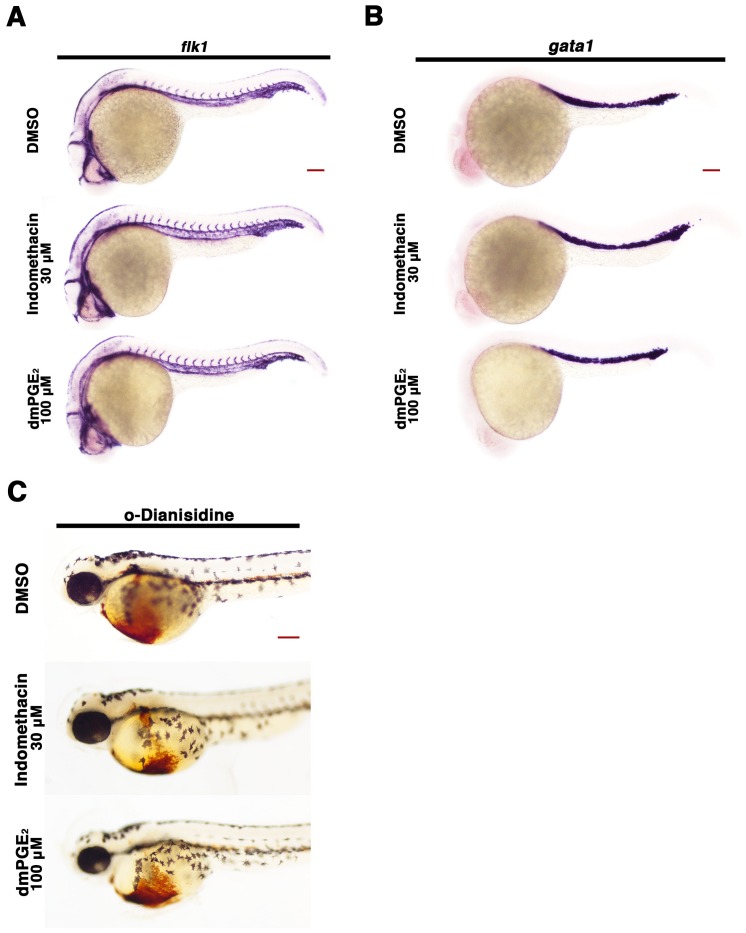
Perturbation of the prostaglandin pathway fails to elicit gross blood or blood vessel abnormalities during development.Embryos were treated with 1% DMSO, 30 μM indomethacin, or 100 μM dmPGE2 from 4 hpf to 24 hpf and WISH was performed to detect (A) vasculature (flk1) and (B) blood precursors (gata1) at the 24 hpf stage. (C) o-dianisidine staining was performed at the 55 hpf stage on embryos treated with 1% DMSO, 30 μM indomethacin, and 100 μM dmPGE2 from 4 hpf to 24 hpf in triplicate with at least 30 embryos. Red scale bar, 70 µm.